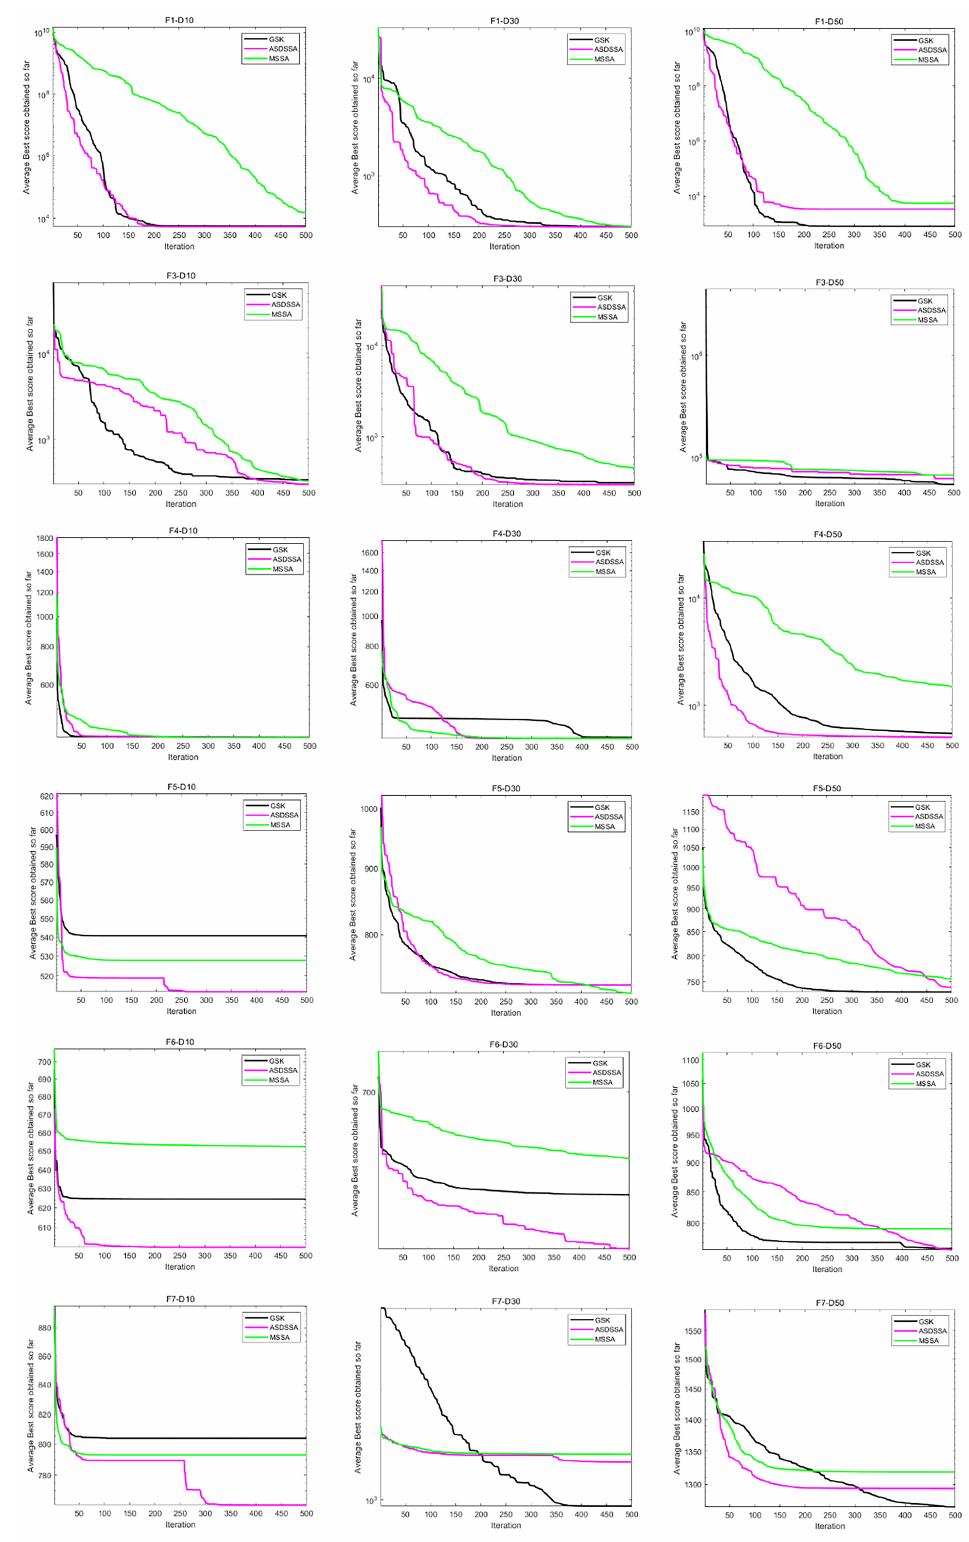
Figure 5. Convergence curves of